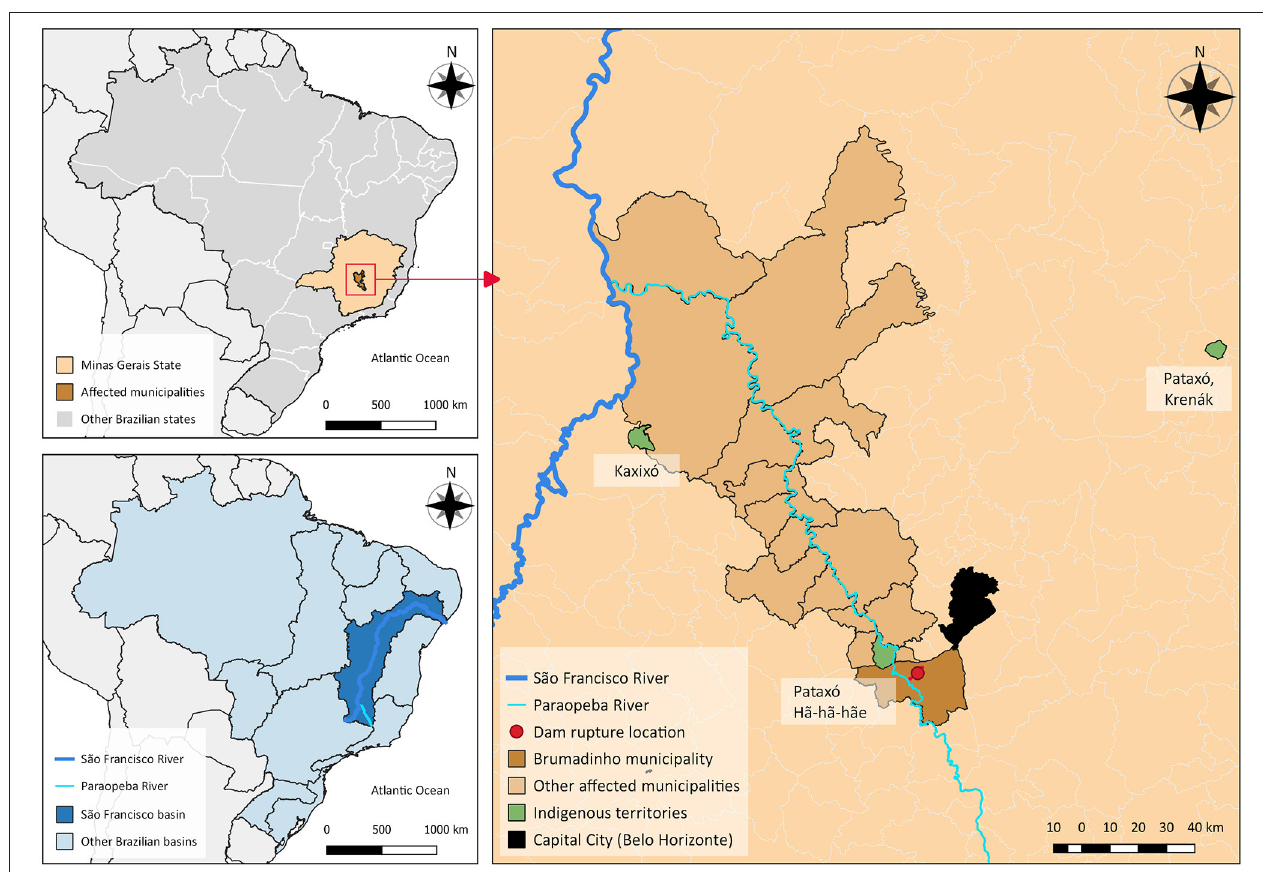
FIGURE 1 | Location of Brumadinho dam rupture, showing the extension of the impact on rivers, municipalities, and Indigenous